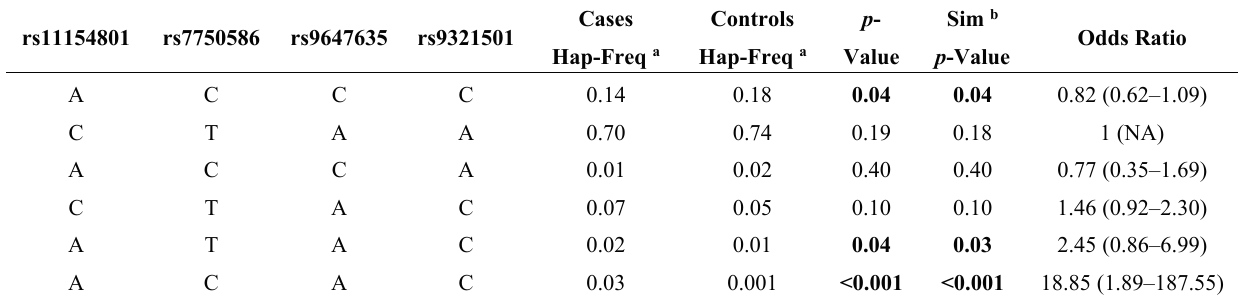
Table 3. Haplotype analyses in the present case-control association